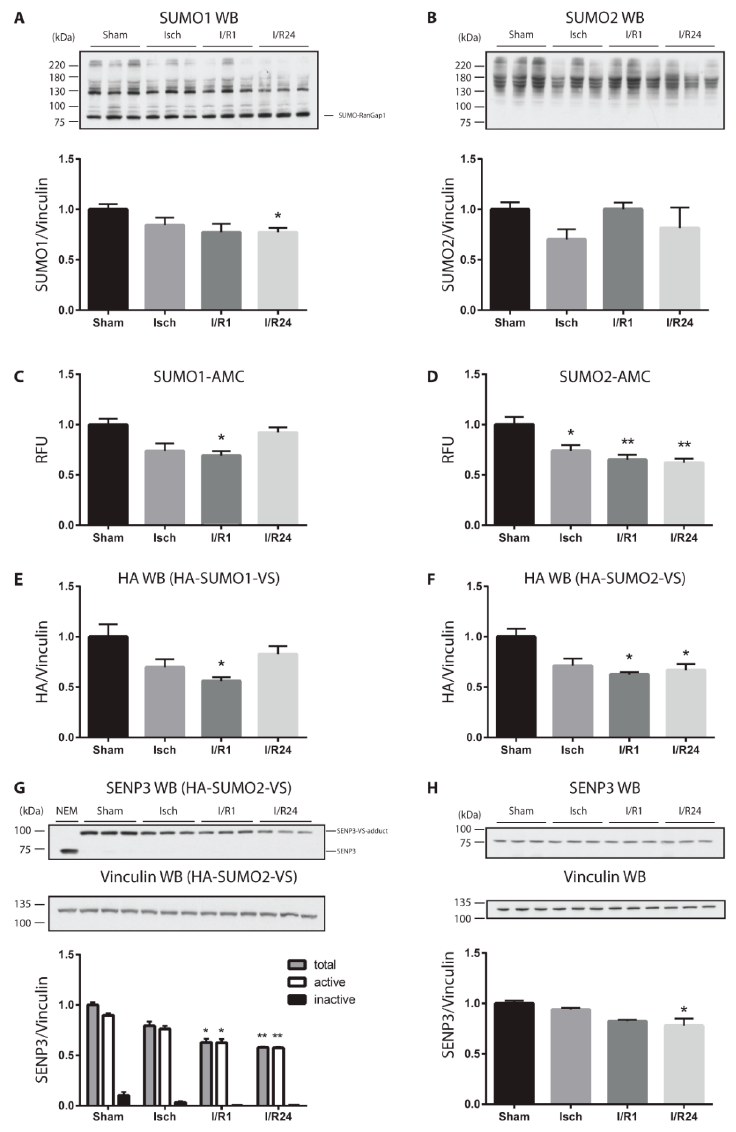
Figure 1. SUMOylation / DeSUMOylation changes dynamically during ischemia and reperfusion in the mouse heart. ( A , B ) Whole homogenates (1% SDS bu ff er) from Sham, ischemic (Isch), and ischemic / reperfused (I / R, reperfusion time 1h or 24 h) left ventricles (LV) of mouse heart were separated by SDS-PAGE. Immunoblotting was performed by anti-SUMO1 ( A ) and anti-SUMO2 antibodies ( B ). ( C , D ) SUMO protease activities in Sham, Isch, I / R1 and I / R24 heart LV homogenates in SEM bu ff er was determined by measuring fluorescence signals emitted from liberated AMC substrate (SUMO1-AMC ( C ) vs. SUMO2-AMC ( D )) over time. RFU: relative fluorescence unit. E – F SUMO protease activities in Sham, Isch, I / R1 and I / R24 LV heart lysates in SEM bu ff er was determined by preincubating the lysates for 15 min at 25 ◦ C with either HA-SUMO1-VS ( E ) or HA-SUMO2-VS ( F ) probes followed by separation of the homogenates by SDS-PAGE. Western blotting was performed by adding anti-HA antibody. HA signal was quantified and normalized to vinculin. ( G ) The HA-SUMO2-VS blot (F) was probed with anti-SENP3 antibody. As for negative control, homogenates were treated with NEM (10 mM) to inhibit cysteine protease activity. ( H ) Whole homogenates (1% SDS bu ff er) from left ventricles (LV) of mouse heart were probed by anti-SENP3 and anti-vinculin antibodies. Vinculin was used as loading control in all cases. Quantification of the respective blots normalized to vinculin are shown. Data are expressed in mean ± SEM, asterisks show significant di ff erences compared to Sham ( n = 3, * p < 0.05, ** p <